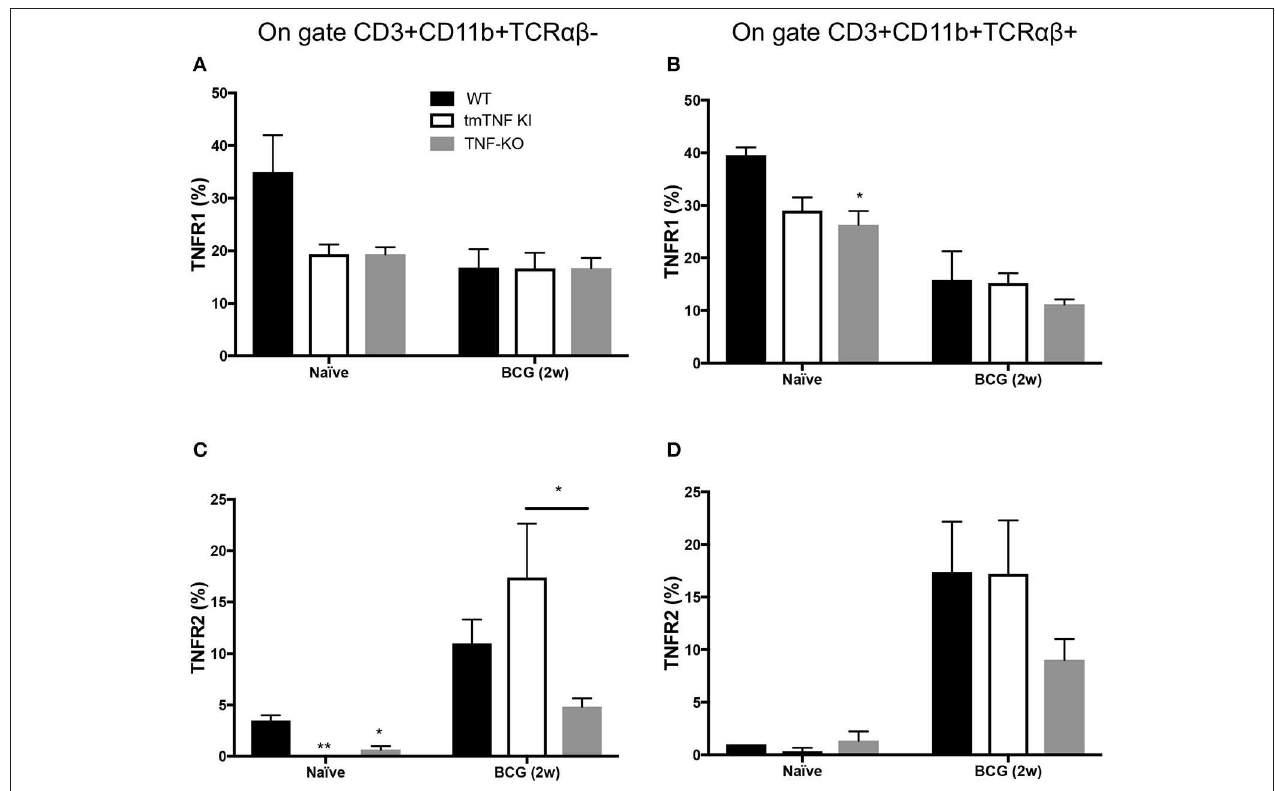
FIGURE 5 | TNFR2 expression increases on CD3 + TCR αβ − and CD3 + TCR αβ + myeloid cells in the pleural cavity after pleural BCG infection. Wild type (WT), transmembrane TNF (tmTNF KI)-expressing and TNF knockout (TNF KO) mice were infected inside the pleural cavity with BCG. Animals were sacrificed at 2 weeks (BCG 2w) post-infection, and a non-infected group (naïve) was used as the control. The frequencies of CD3 + CD11b + TCR αβ − and CD3 + CD11b + TCR αβ + positive to TNFR1 ( A,B , respectively), and the frequencies of CD3 + CD11b + TCR αβ − and CD3 + CD11b + TCR αβ + positive to TNFR2 were reported ( C,D , respectively). The data are expressed as the mean ± SD of n = 4–8 mice, were from three independent experiments. A statistical analysis was performed by two-way ANOVA with multiple comparisons, followed by a Tukey test. * p < 0.05; ** p <